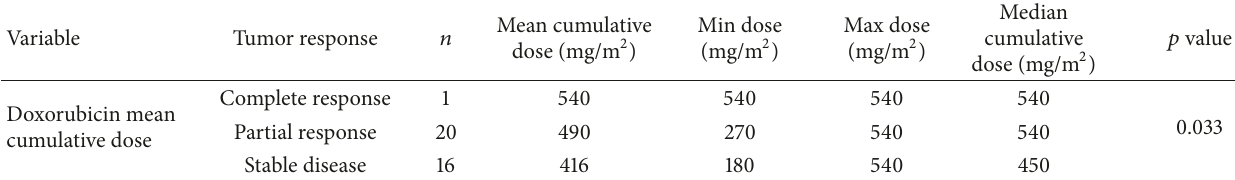
Table 4: Doxorubicin mean cumulative dose and tumor